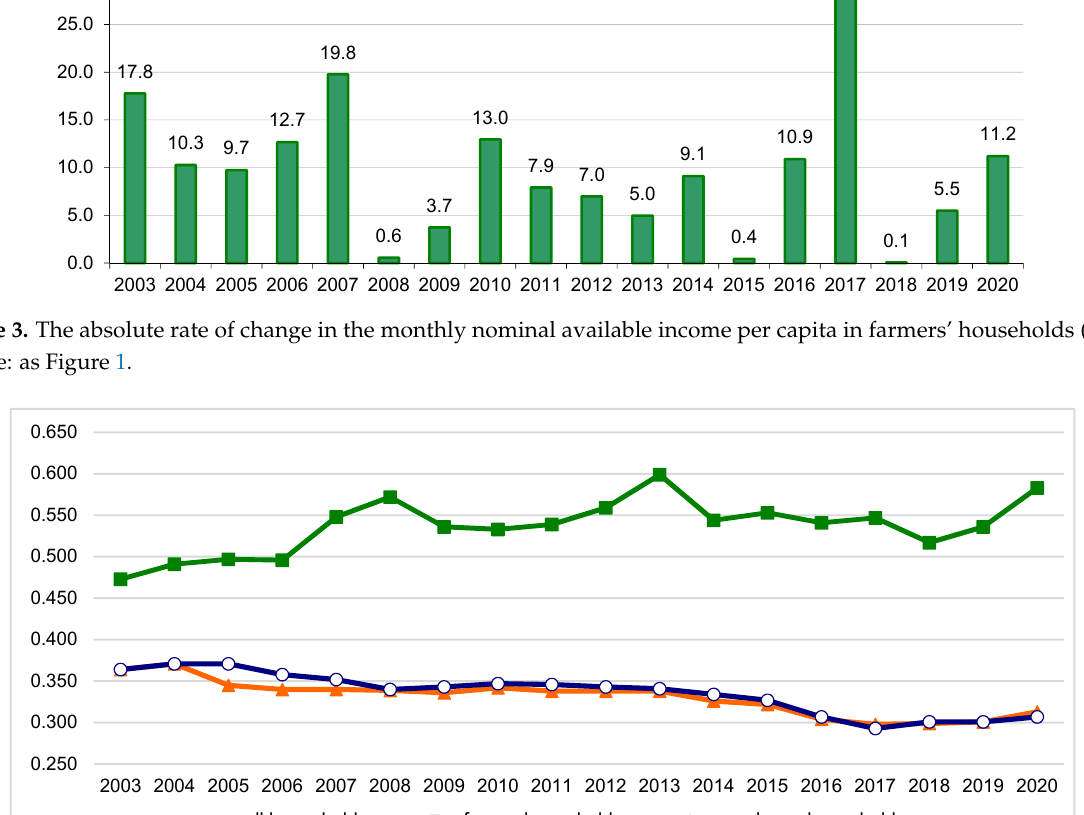
Figure 4. Differences in available income per capita measured by the Gini coefficient in Poland in 2003–2020 for selected groups of households. Source: as Figure 1.